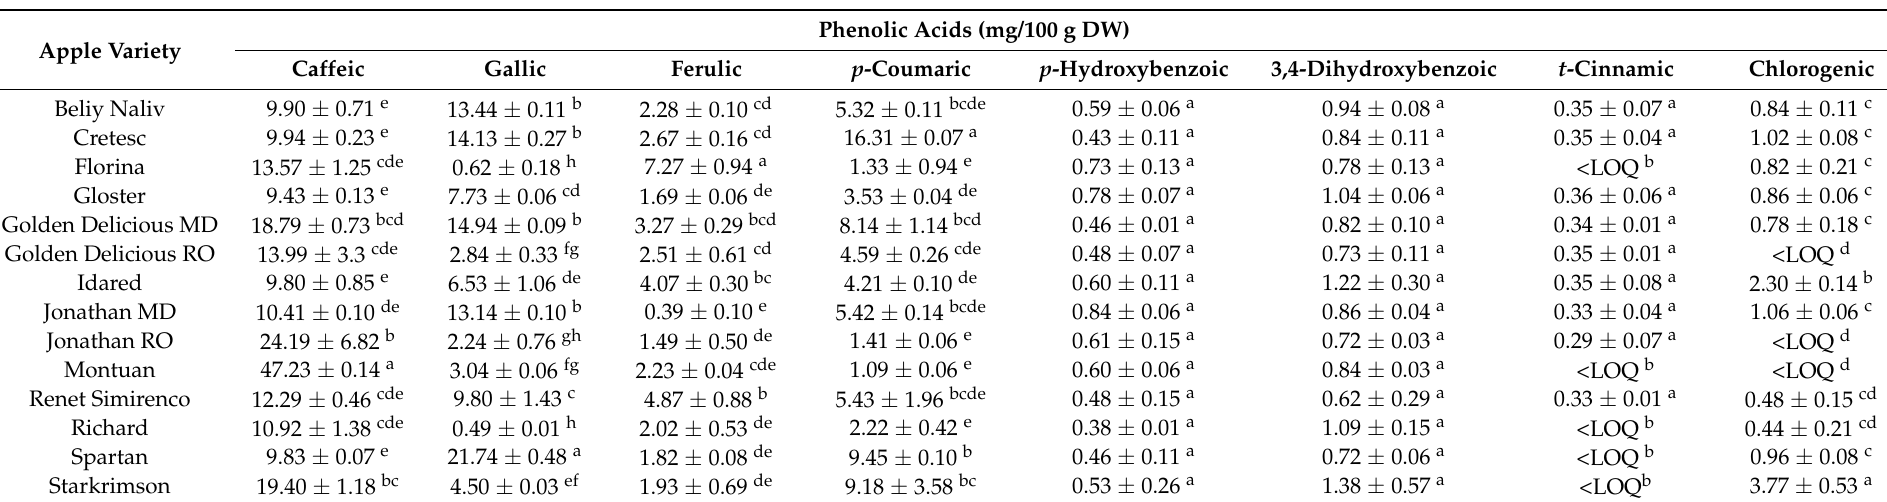
Table 1. Concentration (mg/100 g DW) of phenolic compounds in different apple